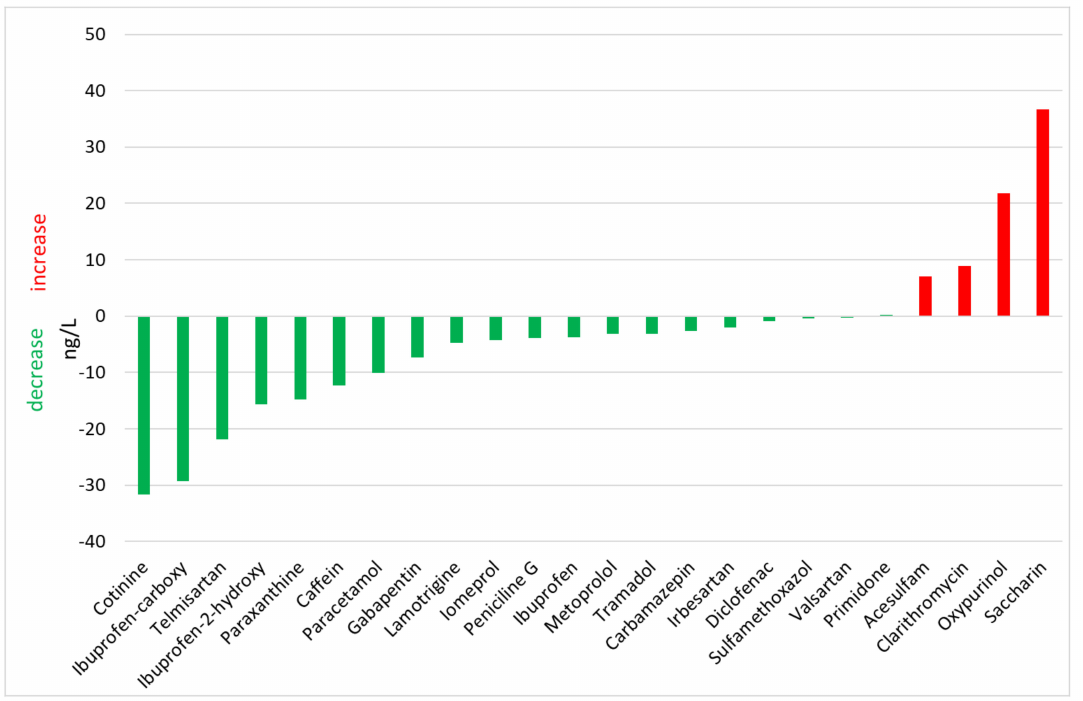
Figure 5. Changes in long-term concentrations of monitored PPCPs between profiles No. 2 and No. 5 Sojovice